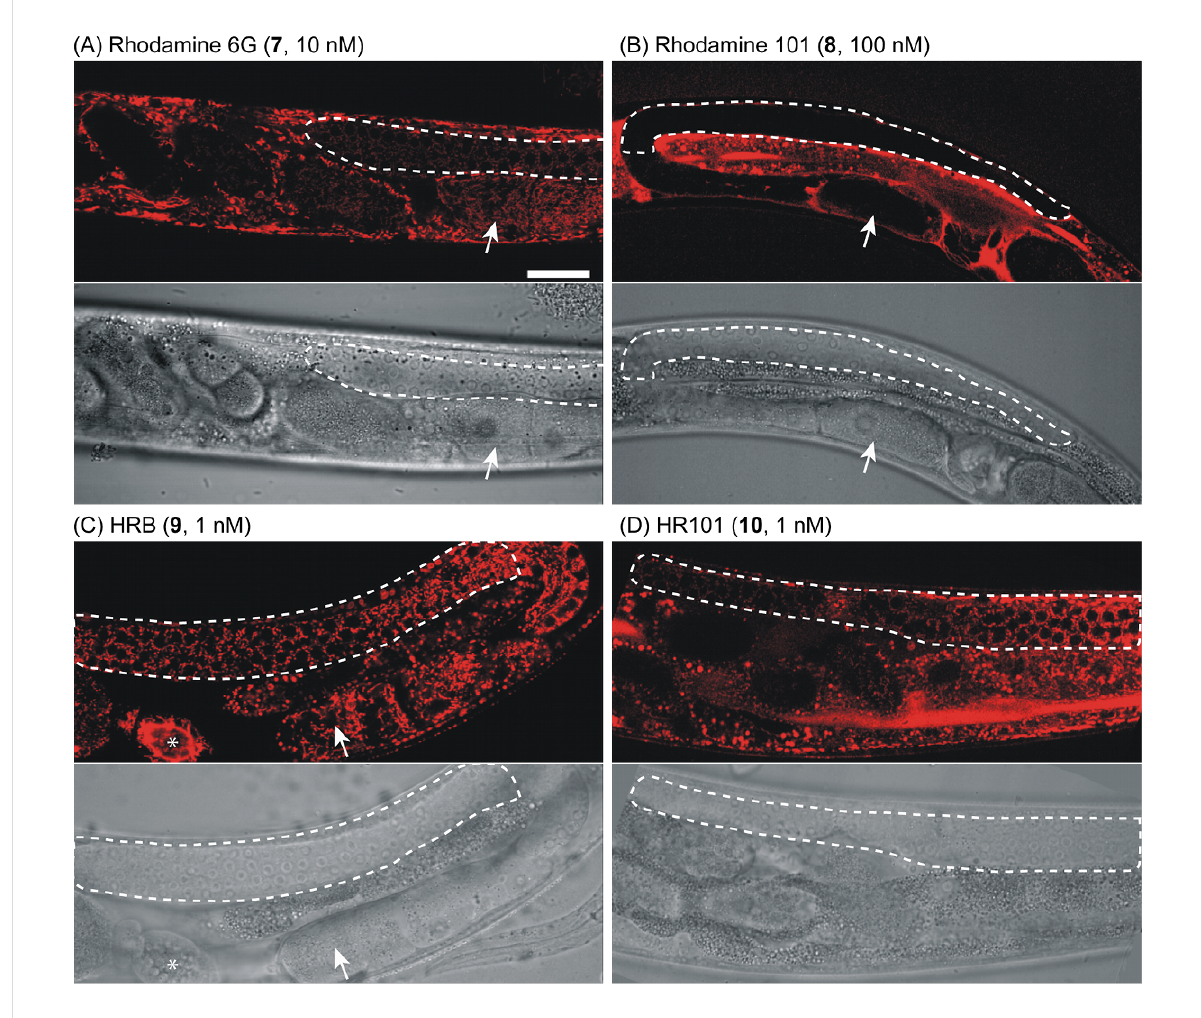
Figure 5: Panels A–D: High magnification confocal (top panels) and DIC micrographs (bottom panels, 60× objective) of young adult C. elegans after treatment with fluorophores for 2 h. The distal gonad containing the germline is shown marked by white dashed lines, the anterior of the animal is to the left, and ventral is down. In Panels C, and D, strong labeling of tubular mitochondria surrounding the mitotic nuclei of the gonad can be observed as well as strong staining of mitochondria within oocytes (white arrows indicate the most proximal oocyte, where visible) and the fibrous organelle (marked with an asterisk in panel C) of spermatheca. Scale bar = 25